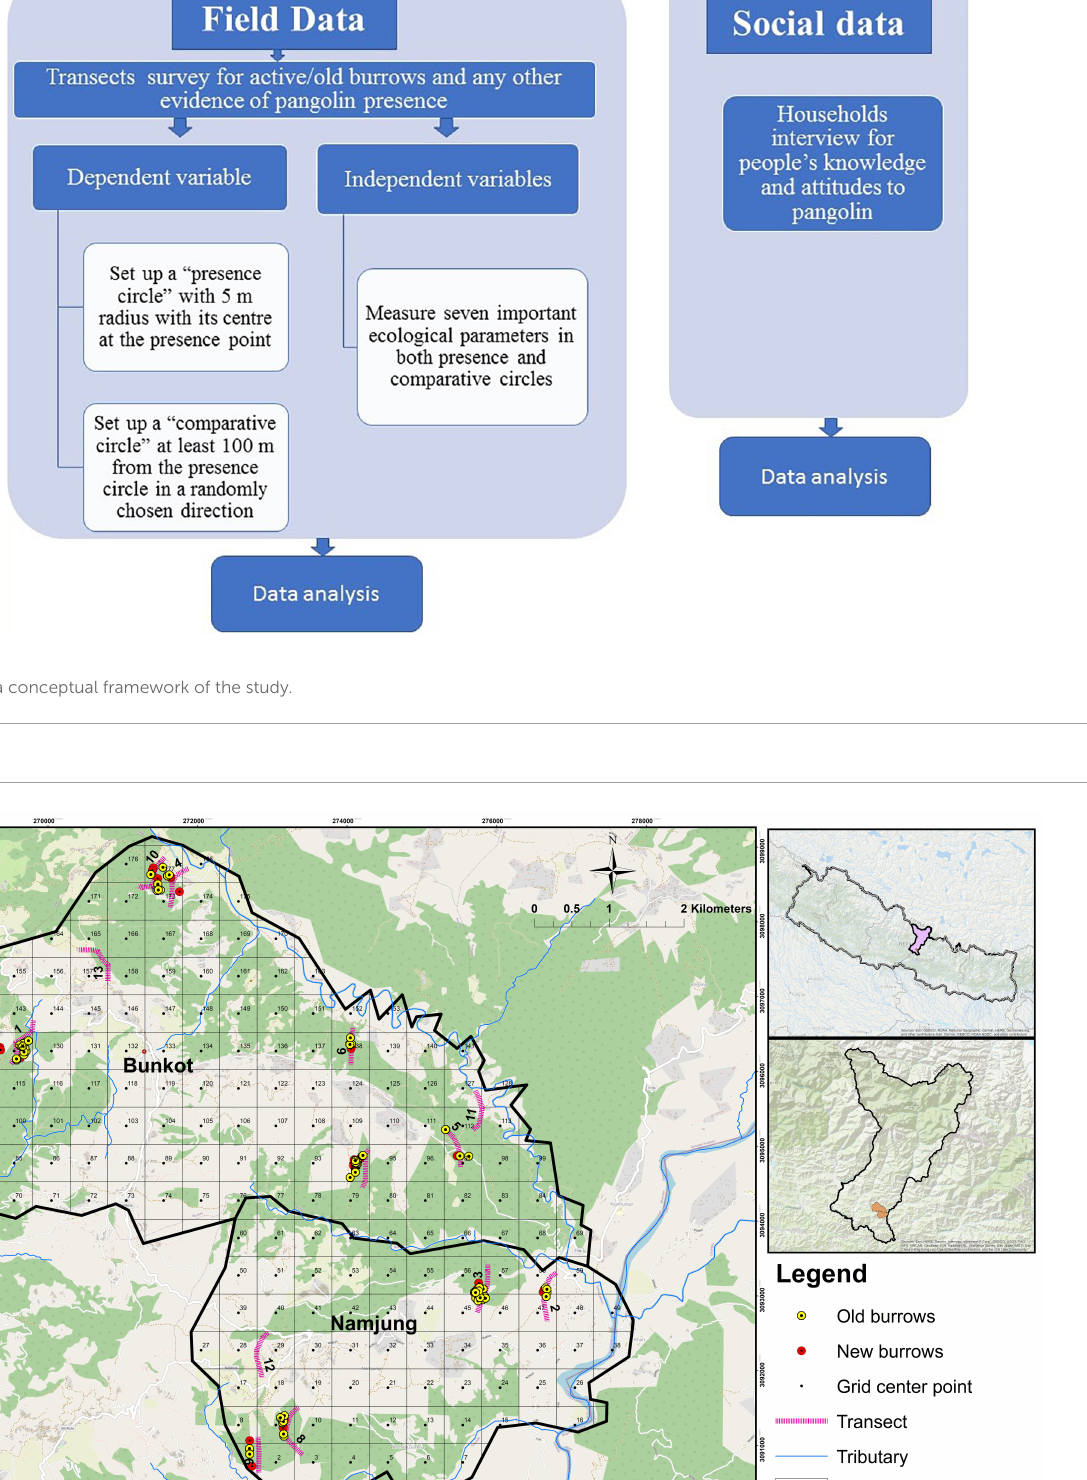
Frontiers in Ecology and Evolution